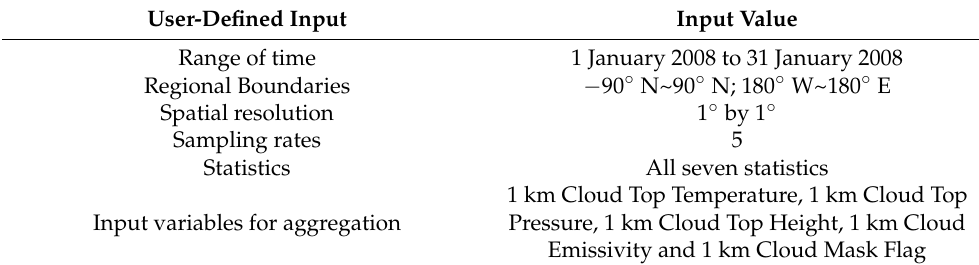
Table 5. The inputs defined for the Speed-up